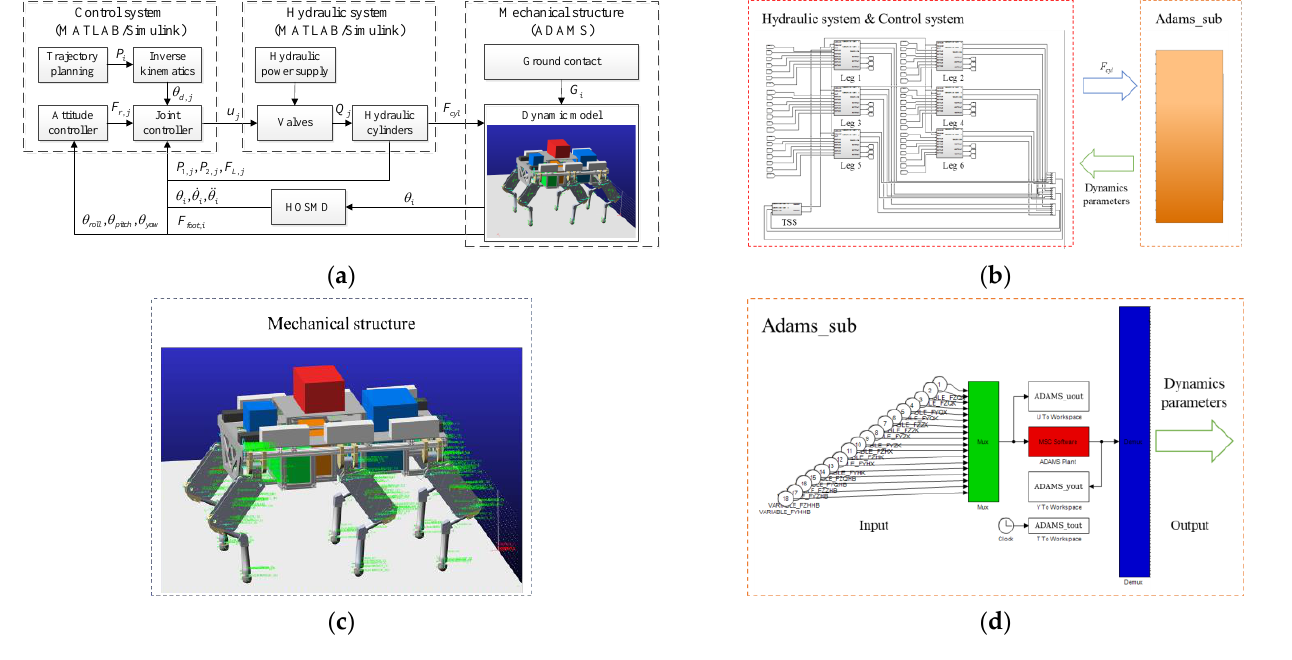
Figure 7. ADAMS and MATLAB co-simulation model: ( a ) The block diagram of the co-simulation model; ( b ) The interactive interface of ADAMS and MATLAB/Simulink; ( c ) The mechanical structure of HHR in ADAMS; ( d ) Adams_sub module in MATLAB/Simulink. Table 3. Ground contact parameters in ADAMS.